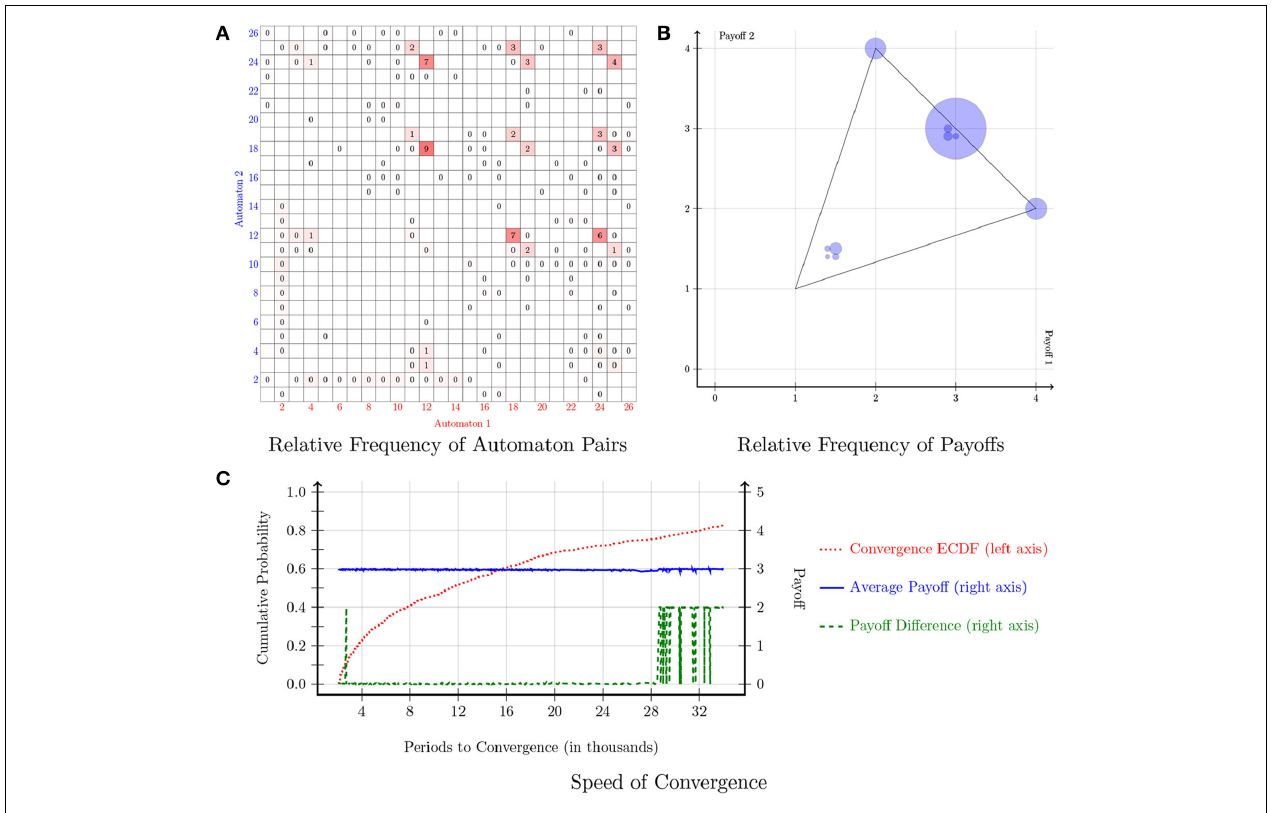
FIGURE 4 | Battle of the